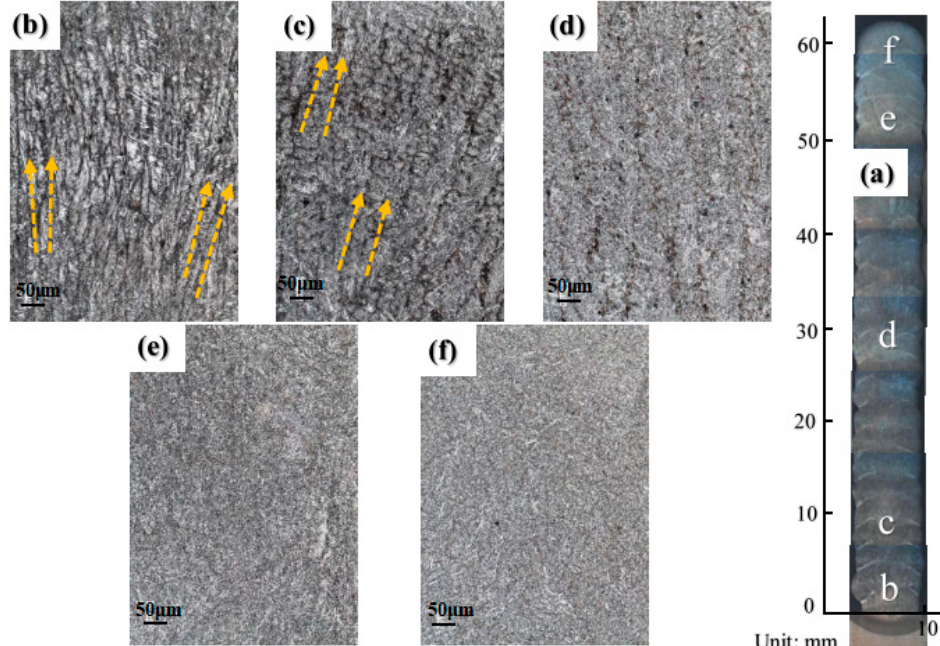
Figure 7. Microstructure evolution for different parts of the as-deposited component: ( a ) Macrostructure of the cross section; ( b ) Region b; ( c ) Region c; ( d ) Region d; ( e ) Region e; ( f ) Region f.